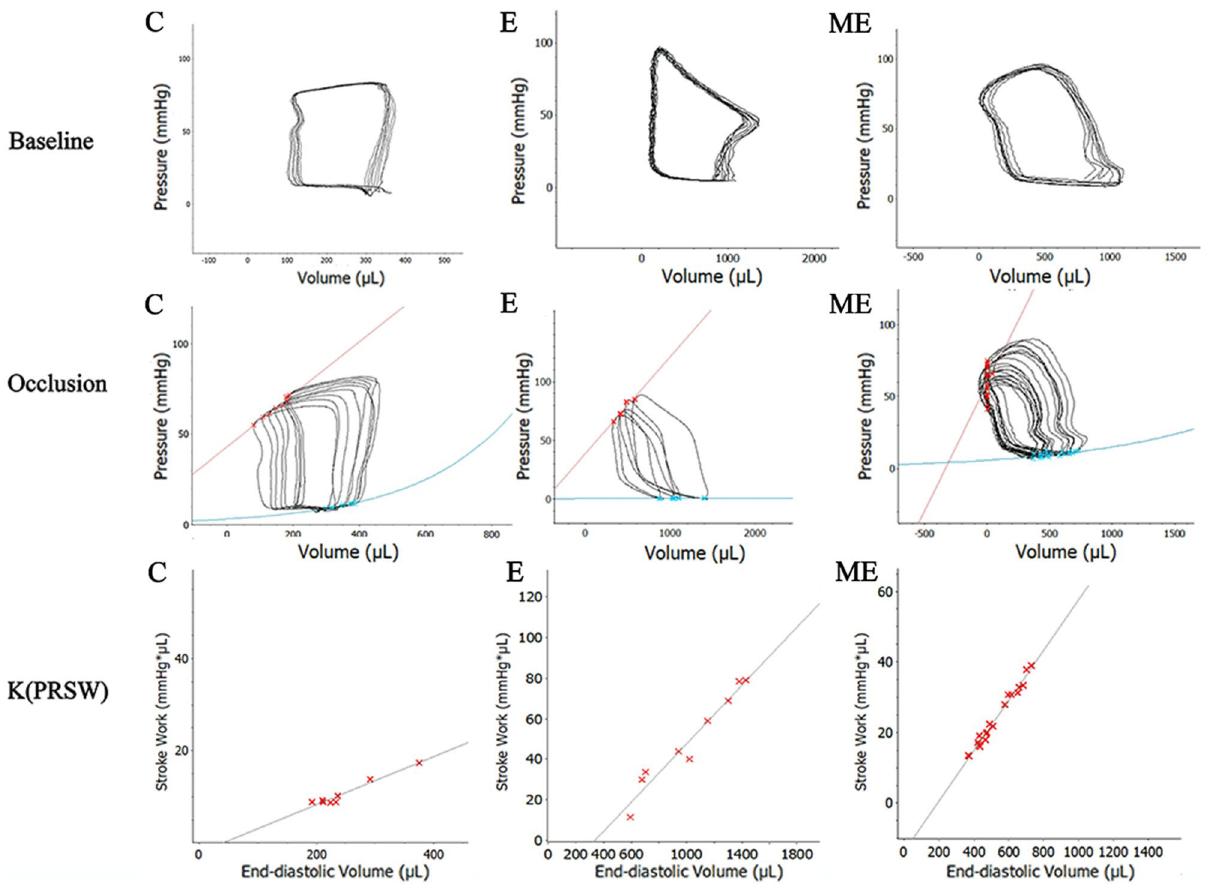
Figure 5. Changes in cardiac hemodynamics after MOTS-c treatment during exercise training. Baseline P–V-loops and after blood flow in the inferior vena cava blood flow was obstructed. Stroke work and the slope of ESPVR (C) [Ees (end-systolic elastance)] in the E and ME were significantly higher than in group C. (C = Control, E = Exercise training, ME = Exercise training combined with MOTS-c treatment).